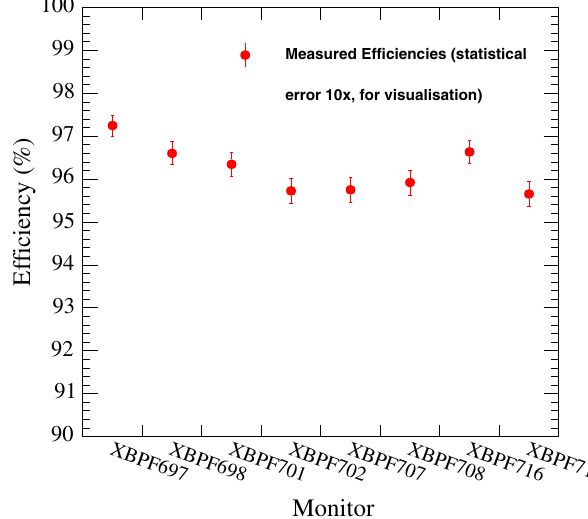
FIG. 20. Measured efficiencies of the fiber profile monitors, calculated as the number of trigger events with at least one channel hit, divided by the number of general triggers.